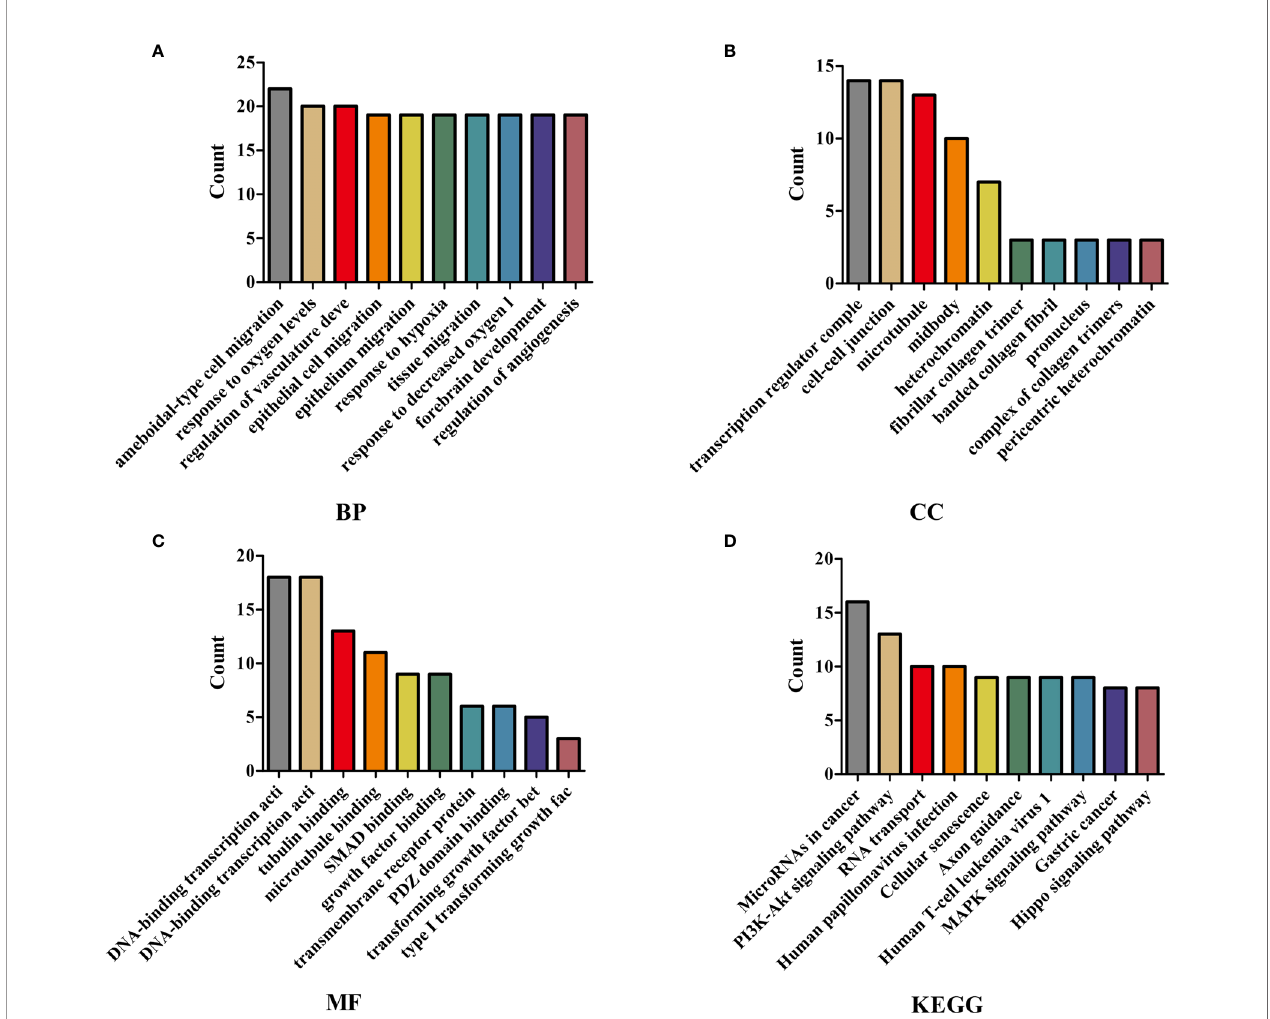
FIGURE 6 | GO and KEGG showed that the biological functions and signaling pathways involved in the ceRNA network mechanism. (A) BP; (B) CC; (C) MF; (D) KEGG. GO, Gene Ontology; KEGG, Kyoto Encyclopedia of Genes and Genomes; BP, Biological process; CC, Cellular components; MF, Molecular